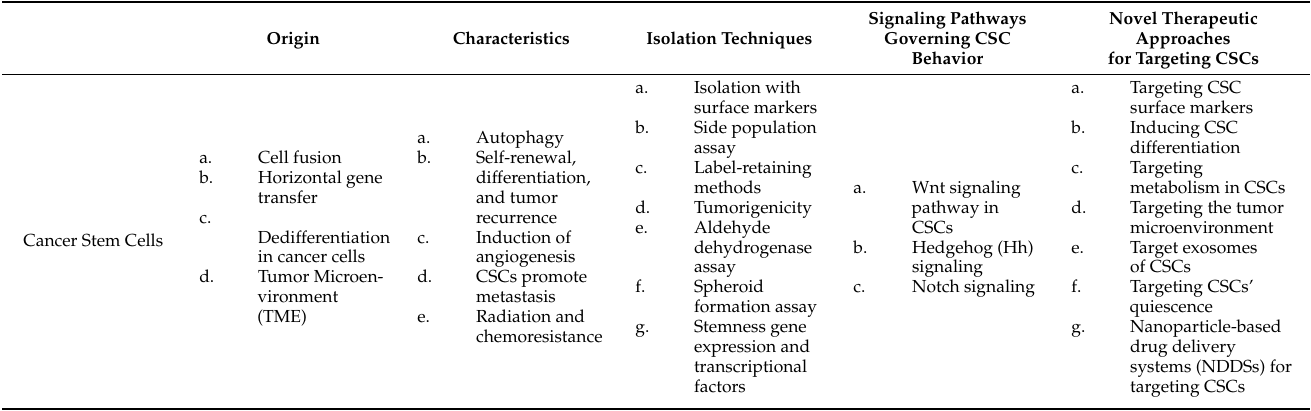
Figure 6. Schematic representation demonstrating that targeting CSCs’ quiescence is a promising approach to tackling drug resistance. Table 1. Representation of all sections with article outcomes.